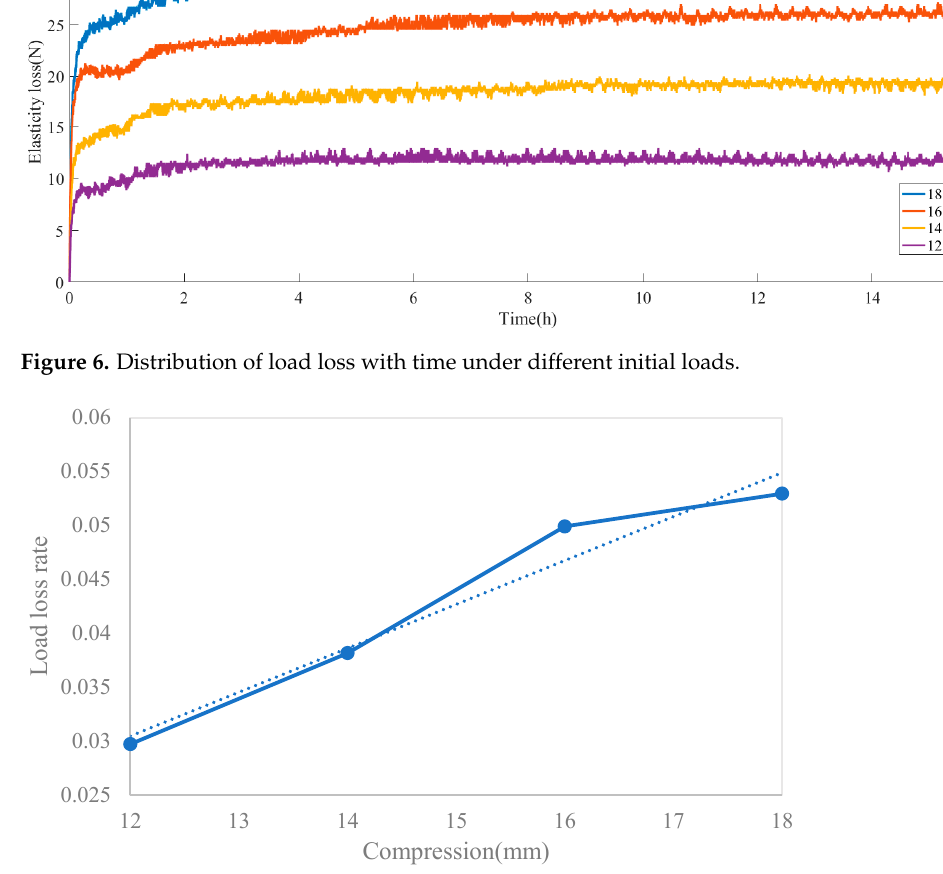
Figure 7. Corresponding diagram of compression and load loss rate.